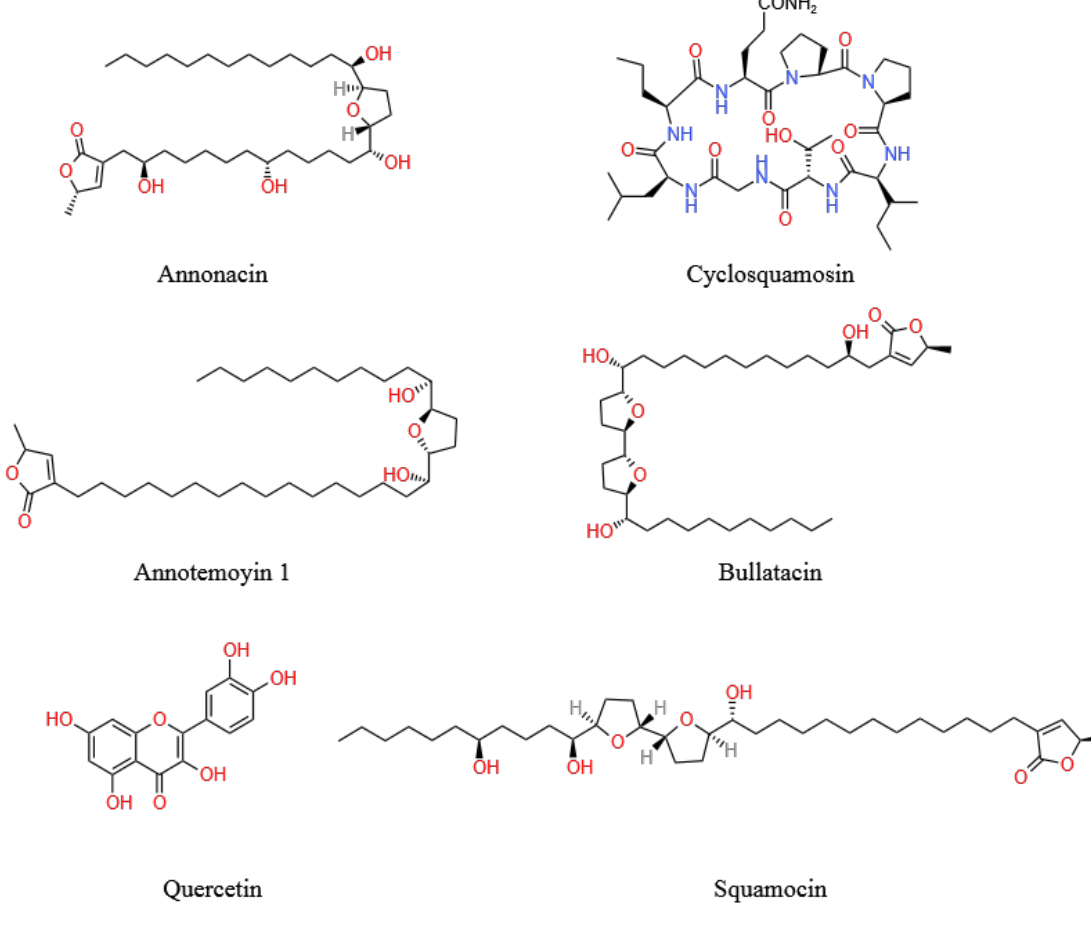
Figure 3. Structure of important compounds found in seeds of A. squamosa.